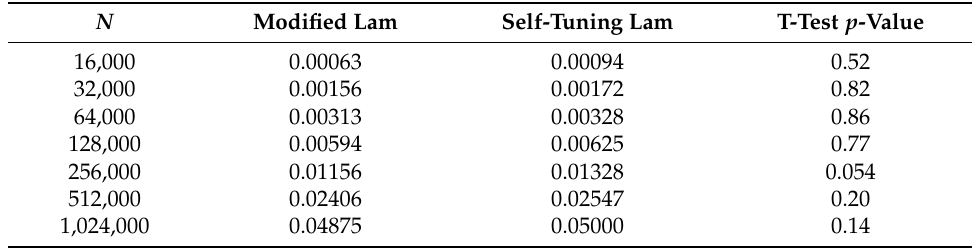
Table 21. Runtime comparison, measured in seconds of CPU time, of the Modified Lam and Self- Tuning Lam annealing schedules. Averages of 100 runs of each run